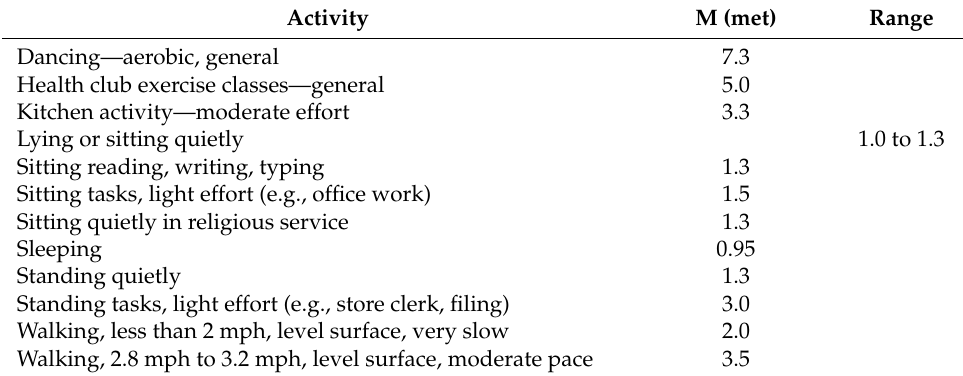
Table 12. Values of physical activity levels